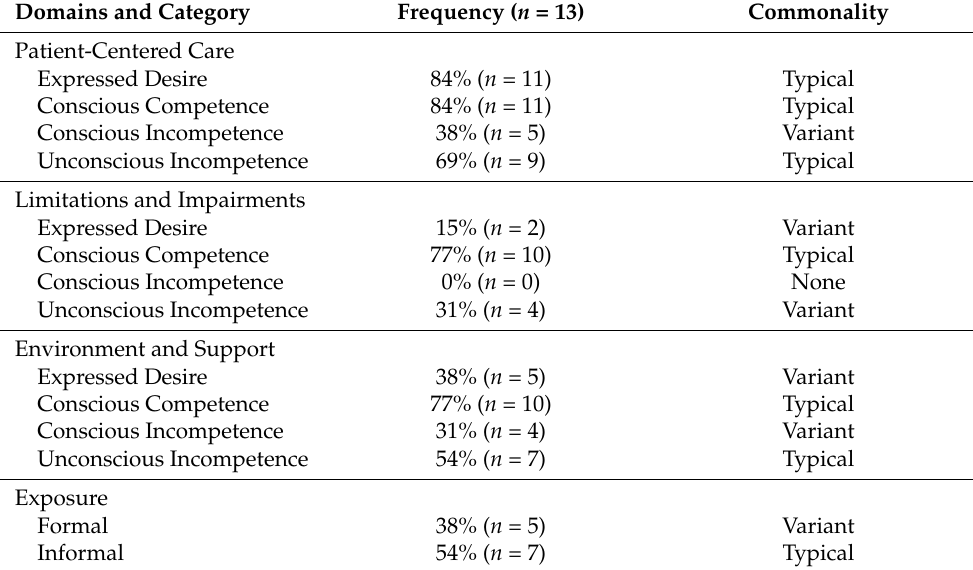
Table 3. Frequency of coded